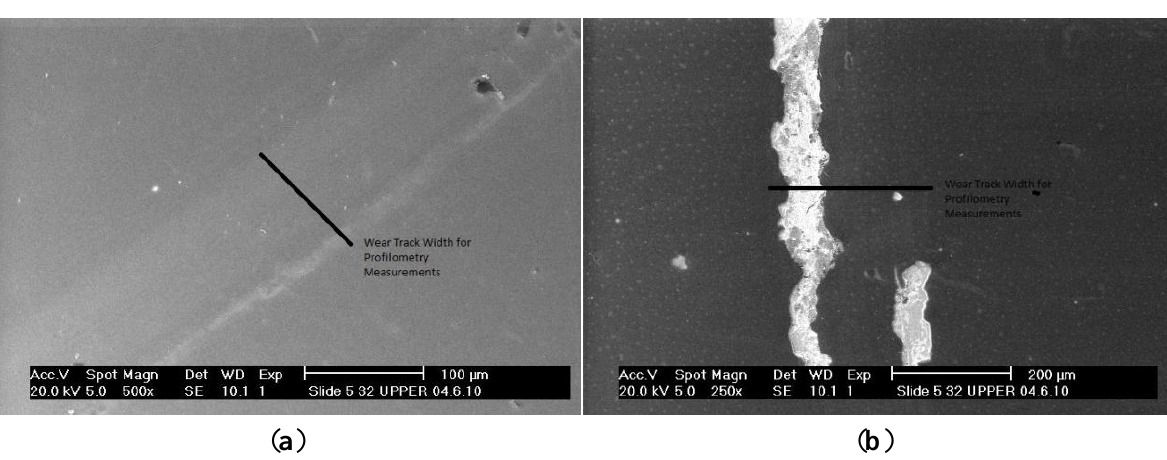
Figure 5. ( a ) SEM of DLC coating DLC-Si-316L-07 wear track (500× Magnification);